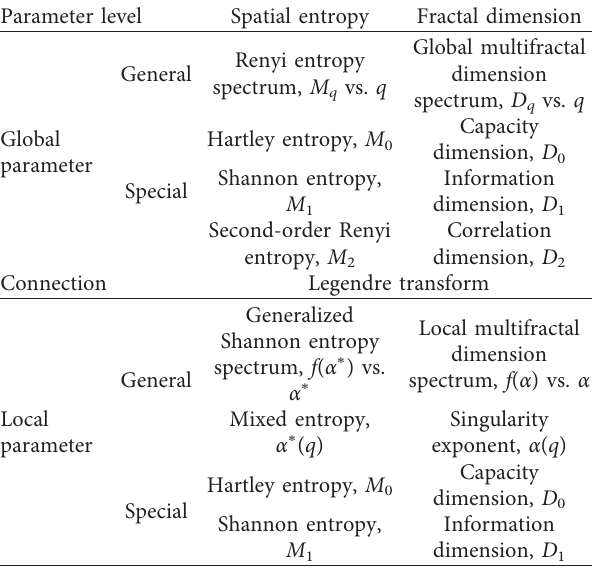
Table 6: The correspondence relationships between spatial entropy spectra and multifractal dimension spectra for spatial analysis of